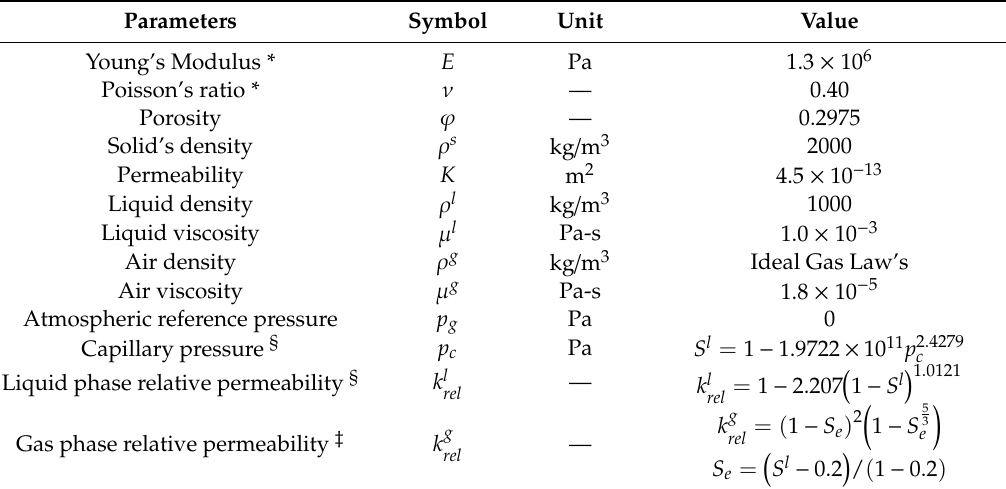
Table 2. Physical parameters for the Liakopoulos